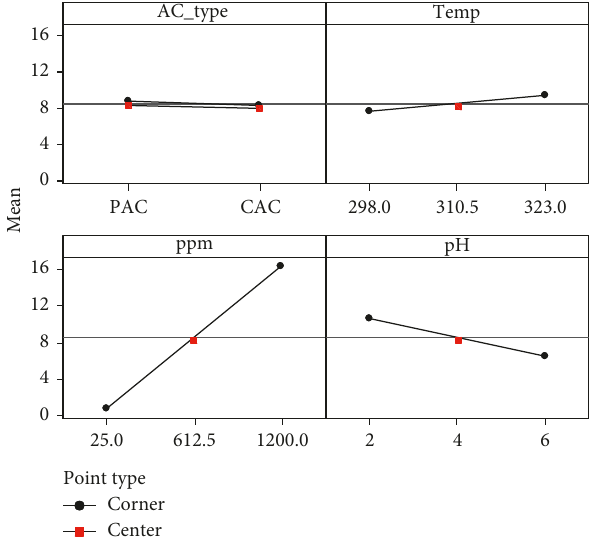
Figure 5: Main effects plot for q e (Data Concentration Effect on Chromium(VI)